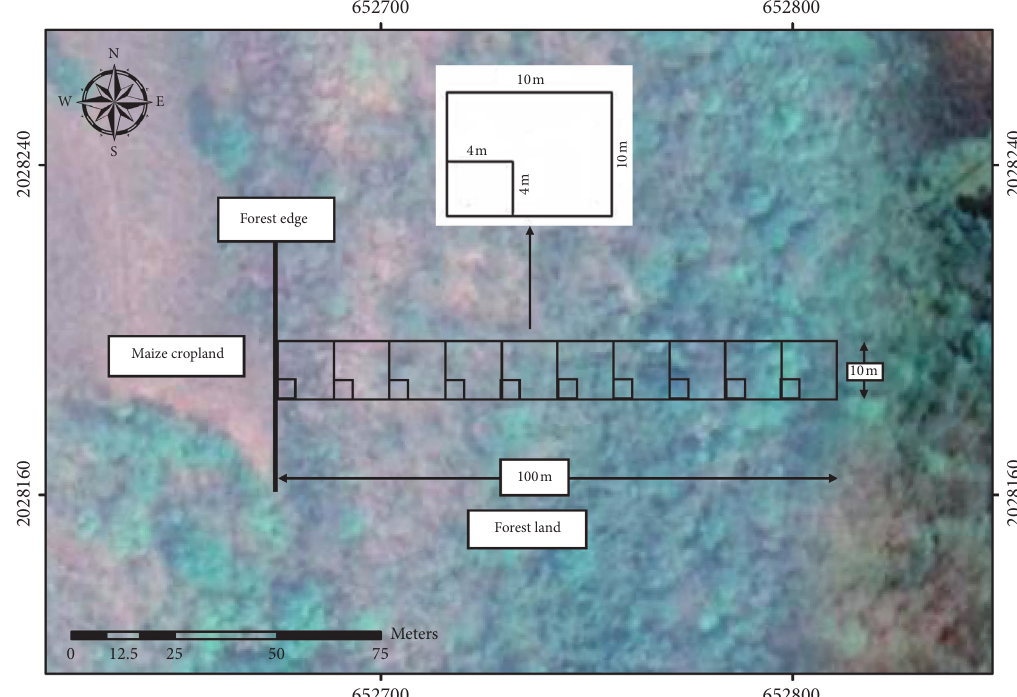
Figure 2: Belt plots (10 × 100m) were established in a deciduous dipterocarp forest (DDF) and a mixed deciduous forest (MDF) at the transition point from the edge to the interior of the forest in the Mae Khum Mee subwatershed, Phrae Province.